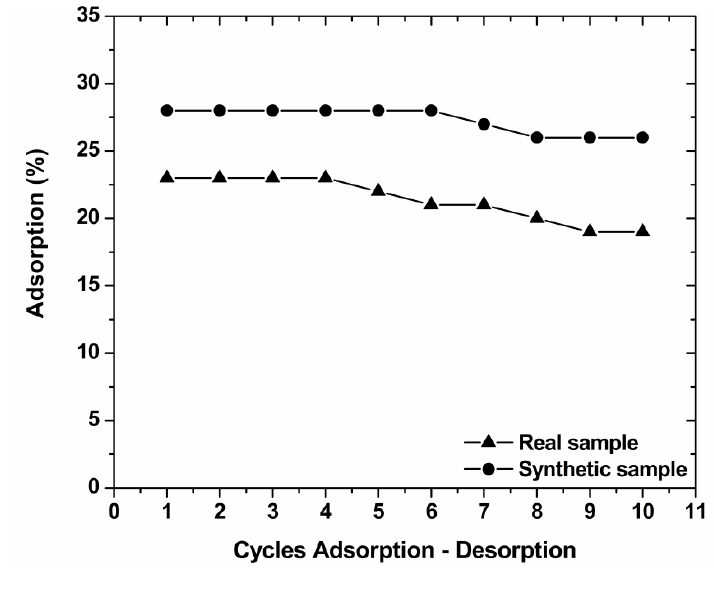
Figure 8. Cycles of adsorption-desorption for the reuse of COF for decolorization of real and synthetic textile effluent (pH 24 h